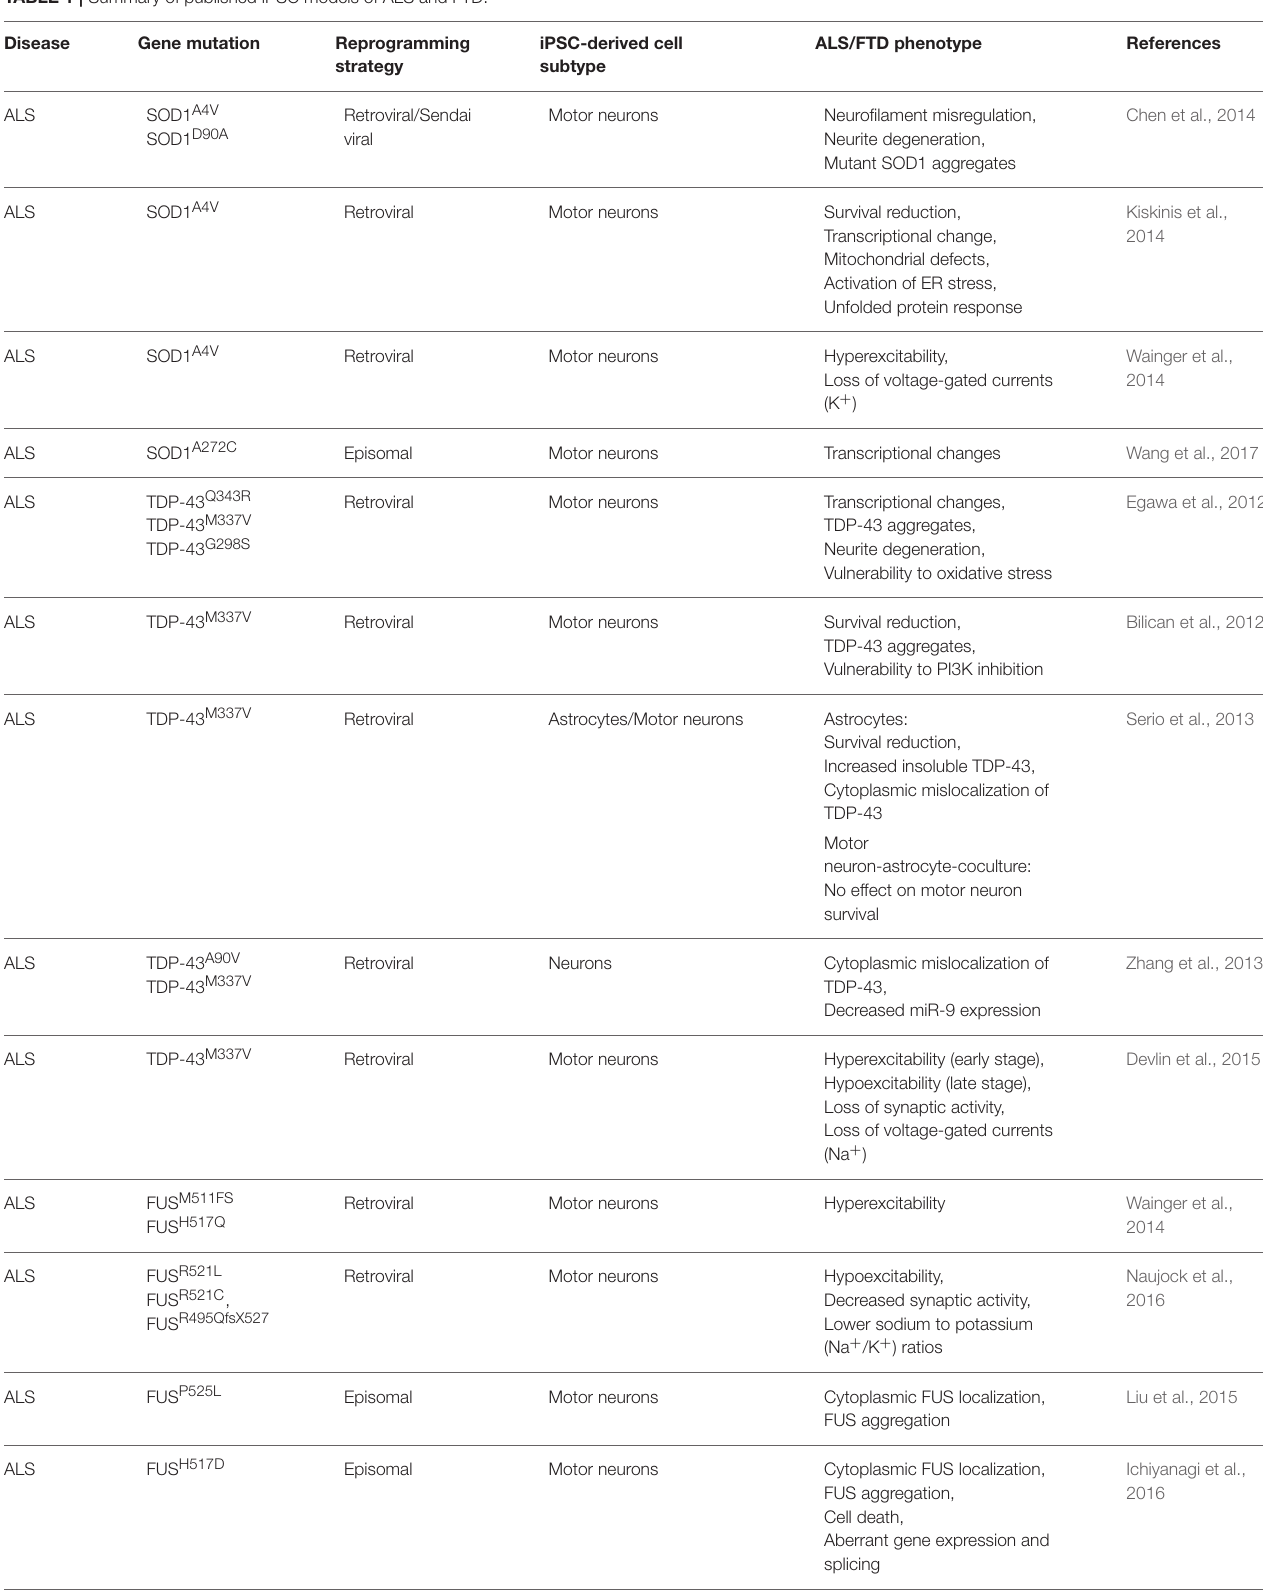
TABLE 1 | Summary of published iPSC models of ALS and FTD.